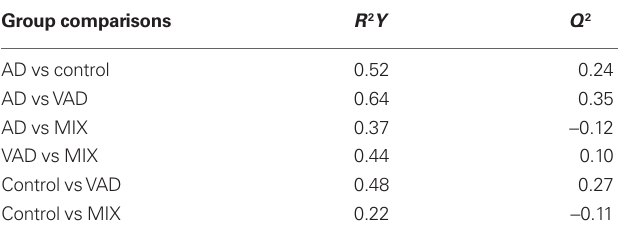
Table 3 | R 2 Y and Q 2 values for the multivariate statistics. group comparisons R 2 Y Q